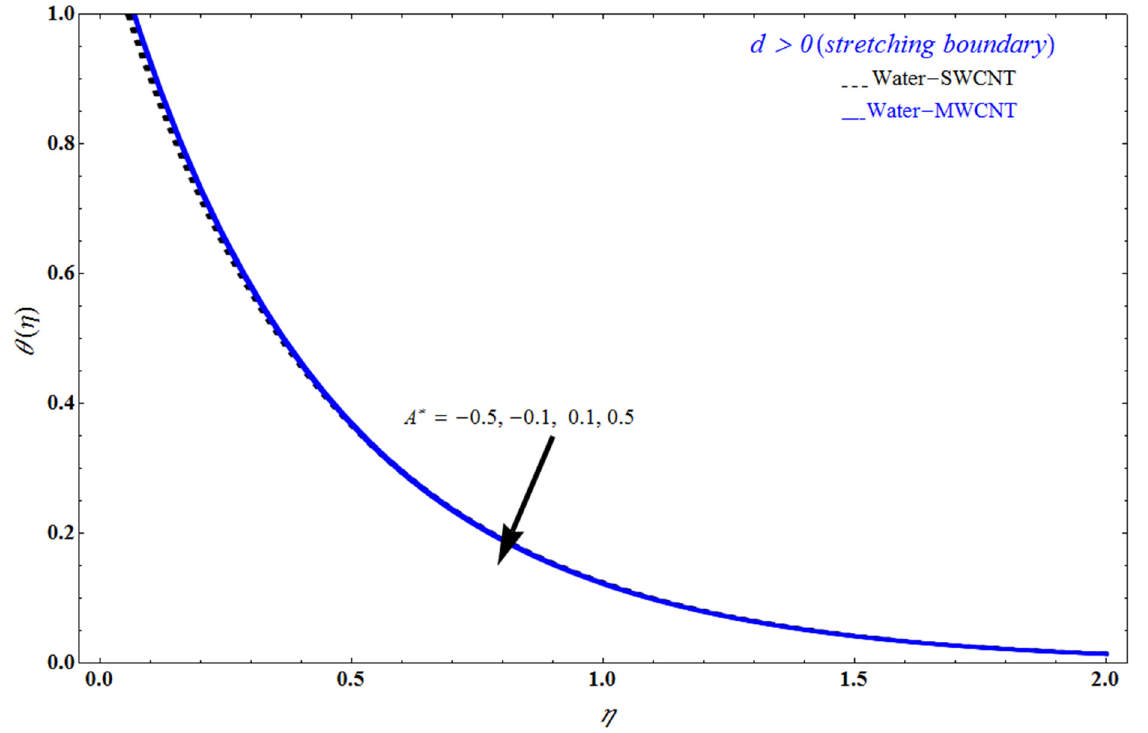
Figure 8. Effect of temperature profile θ ( η ) versus similarity variable η for several values of Ec , respectively.